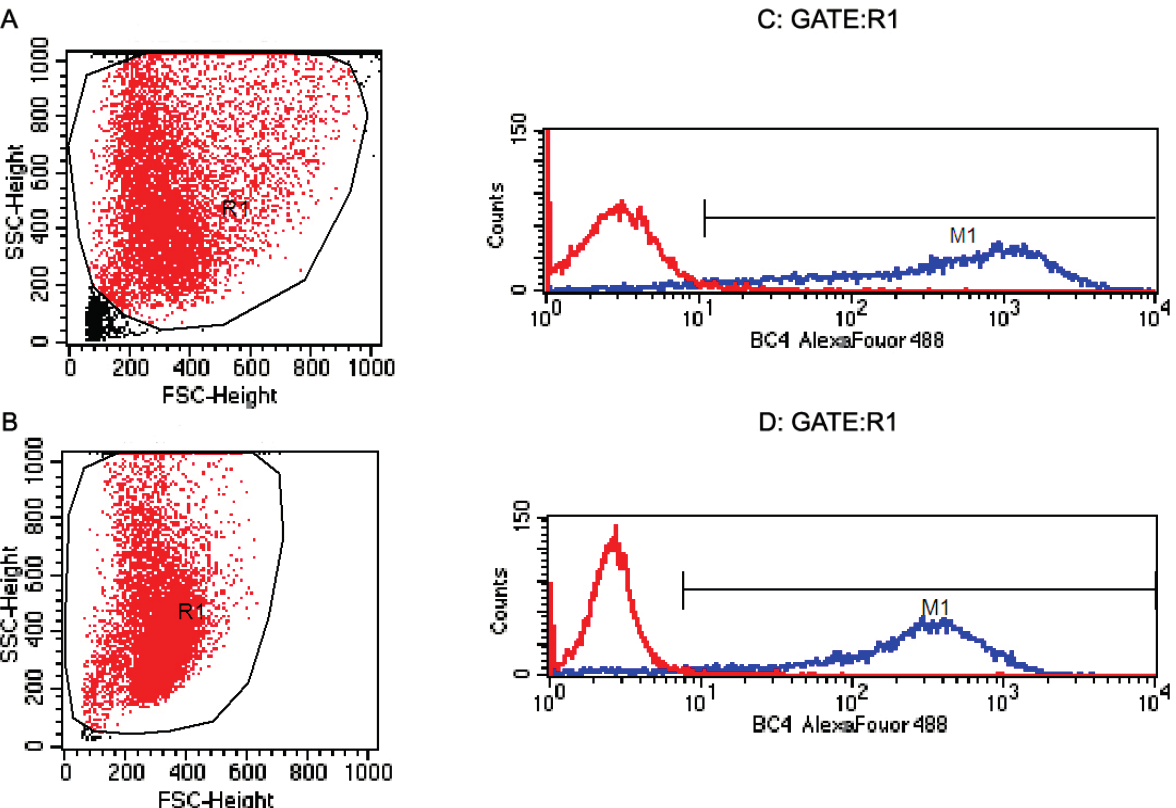
Figure 2. Flow cytometry of the surface expression of on rat BMMCs. Cell were analyzed by flow cytometry for cell size by both FSC and SSC ( A , B ); and for surface expression of the BC4 ( C , D ) antigen. Controls with red line in ( C , D ) were only treated with the secondary antibody. The blue lines in ( C , D) were for the membrane protein for the primary antibody, BC4, and the 2nd antibody. High fluorescent events have very high BC4 (Fc ε RI) fluorescence and their distribution in BMMCs. These confirm that more than 95% of the cells were BC4 positive. Normal rat BMMCs ( A , C ); Asthmatic rat BMMCs ( B , D